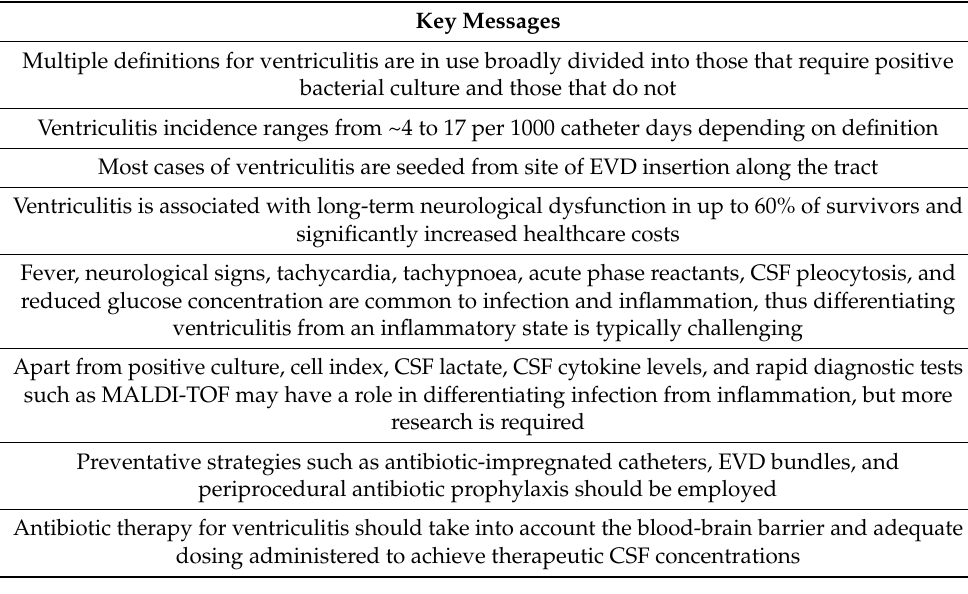
Table 2. Key Messages.